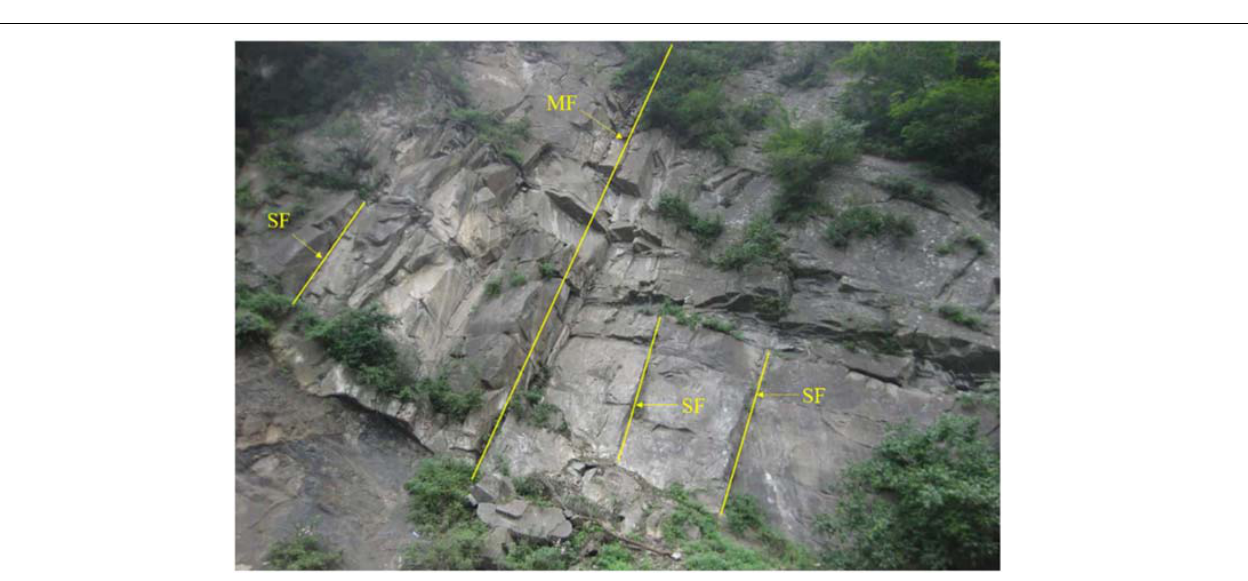
statistical results show that as the fracture size increases, the density of fracture decreases, and the density of micro-scale fractures is the